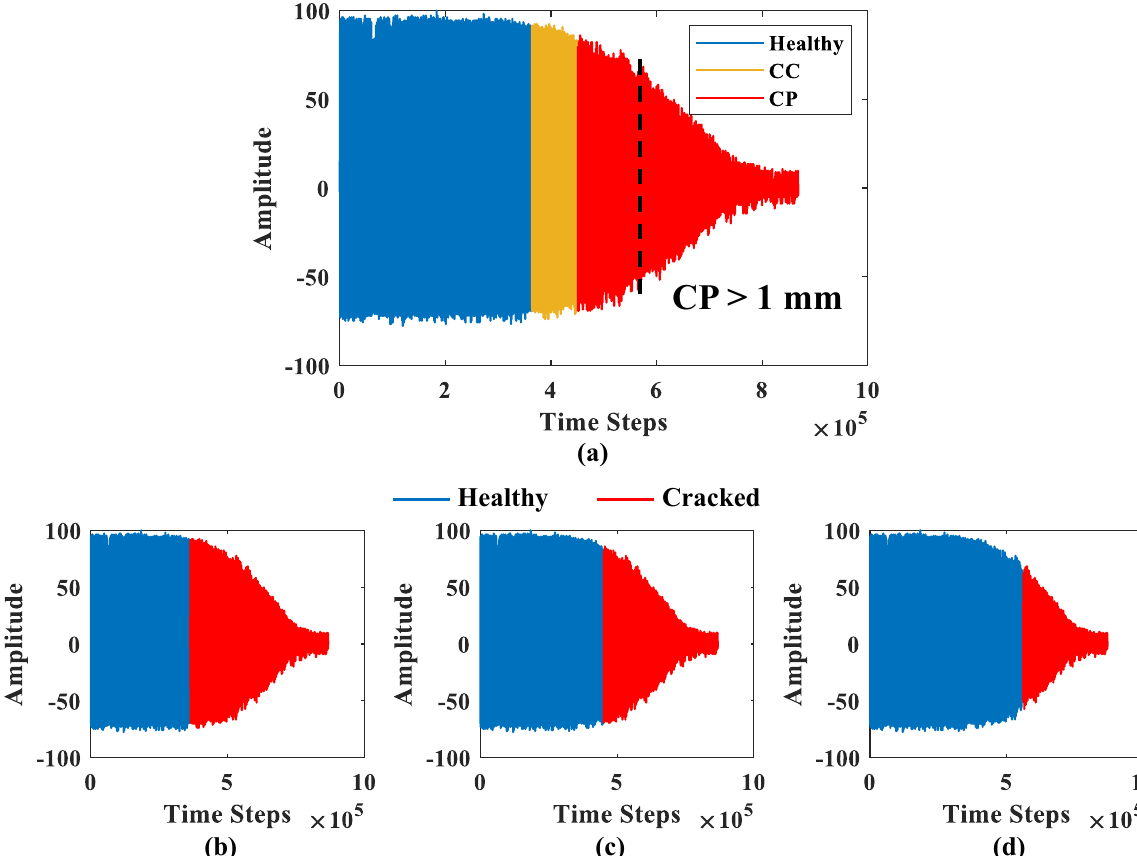
Figure 13. ( a ) The original ultrasonic signal depicting four different regimes. The labeled data for the ( b ) CC, ( c ) CP, and ( d ) CP > 1 mm regimes, illustrating the transition point between a healthy and cracked regime.